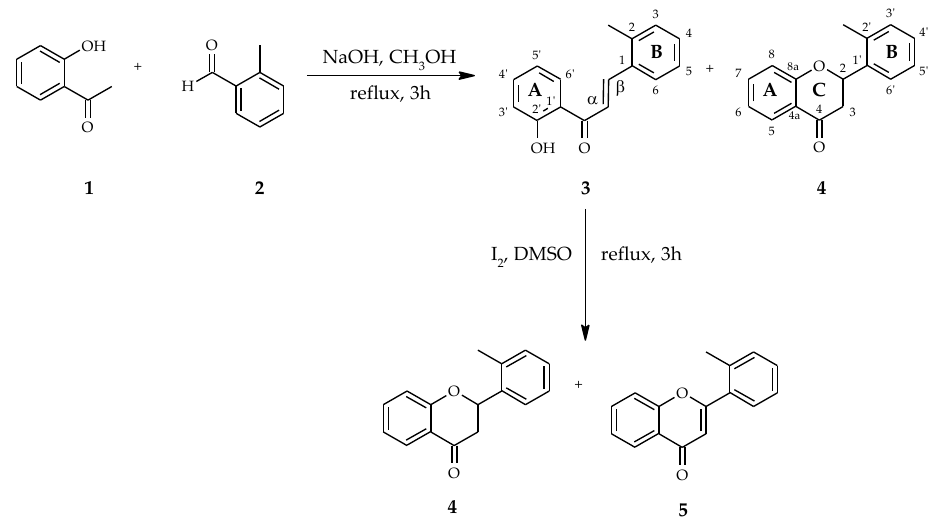
Scheme 1. Synthesis of 2 (cid:48) -methylflavanone ( 4 ) and 2 (cid:48) -methylflavone ( 5